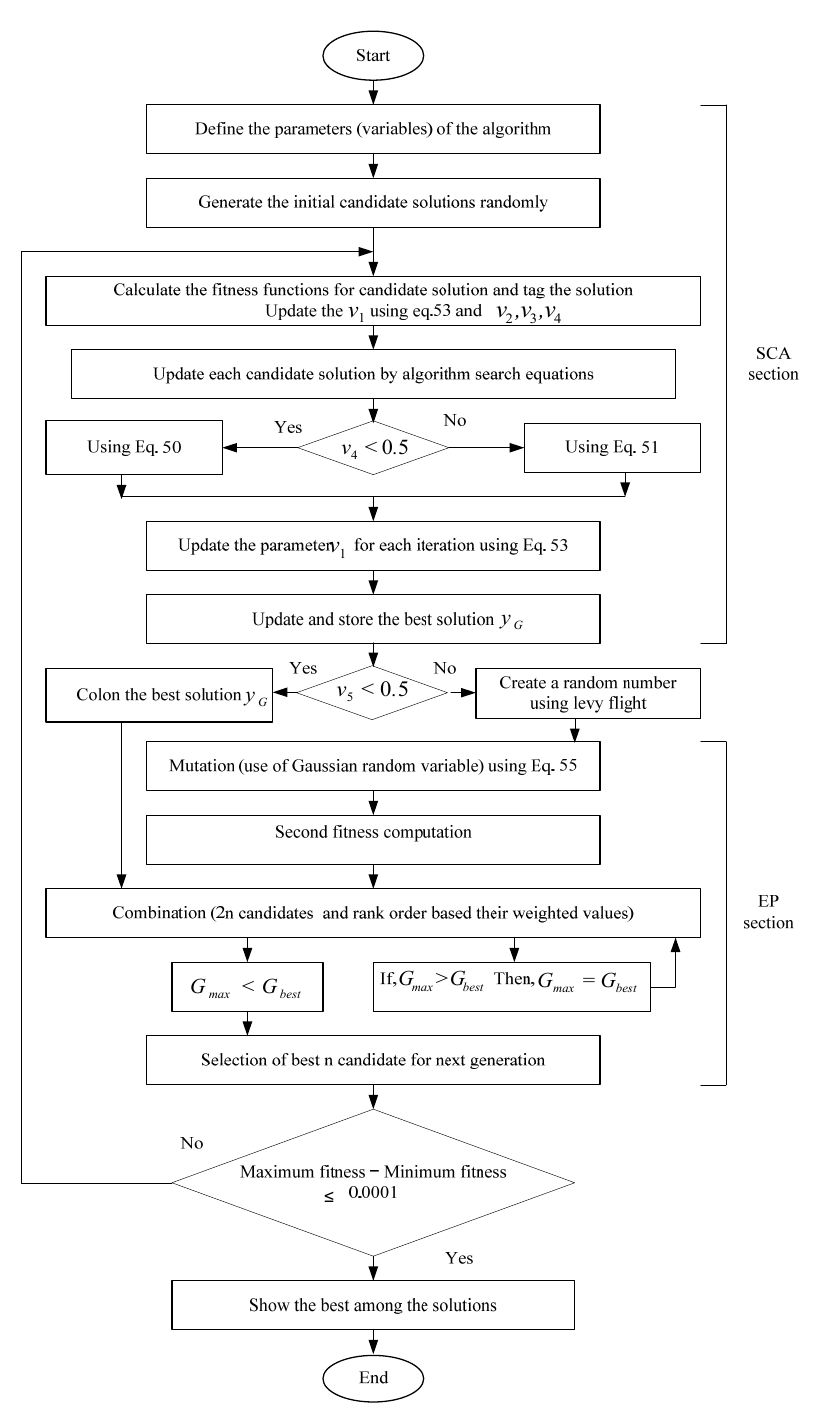
Figure 6. EPSCA flowchart.